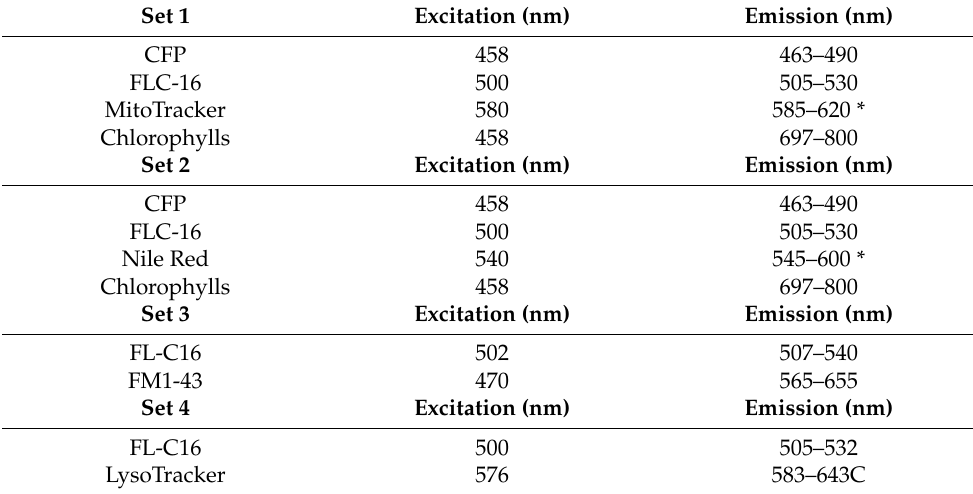
Table 2. Optical conditions to resolve spectra of probes individually. Set